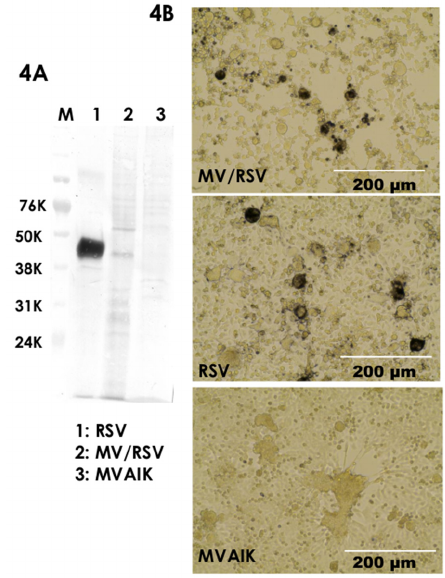
Figure 4. Expression of RSV F protein on MV/RSV chimera virus particle. Western blotting of the RSV, MV/RSV, and MVAIK was examined using monoclonal antibody against RSV F protein ( A ).